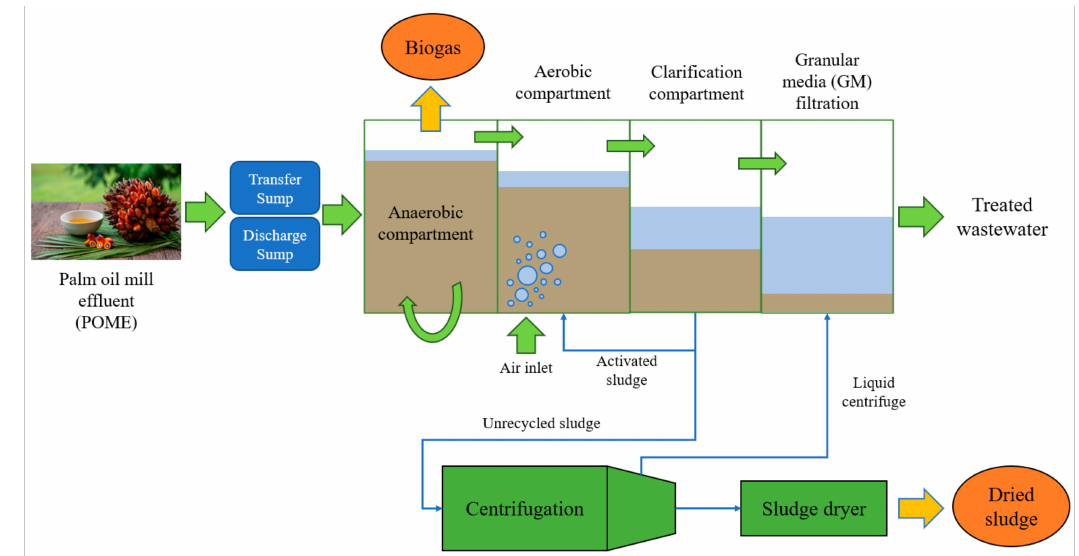
Figure 1. Configuration of IAAB system for the treatment of POME at industrial scale adapted from Chan et al.